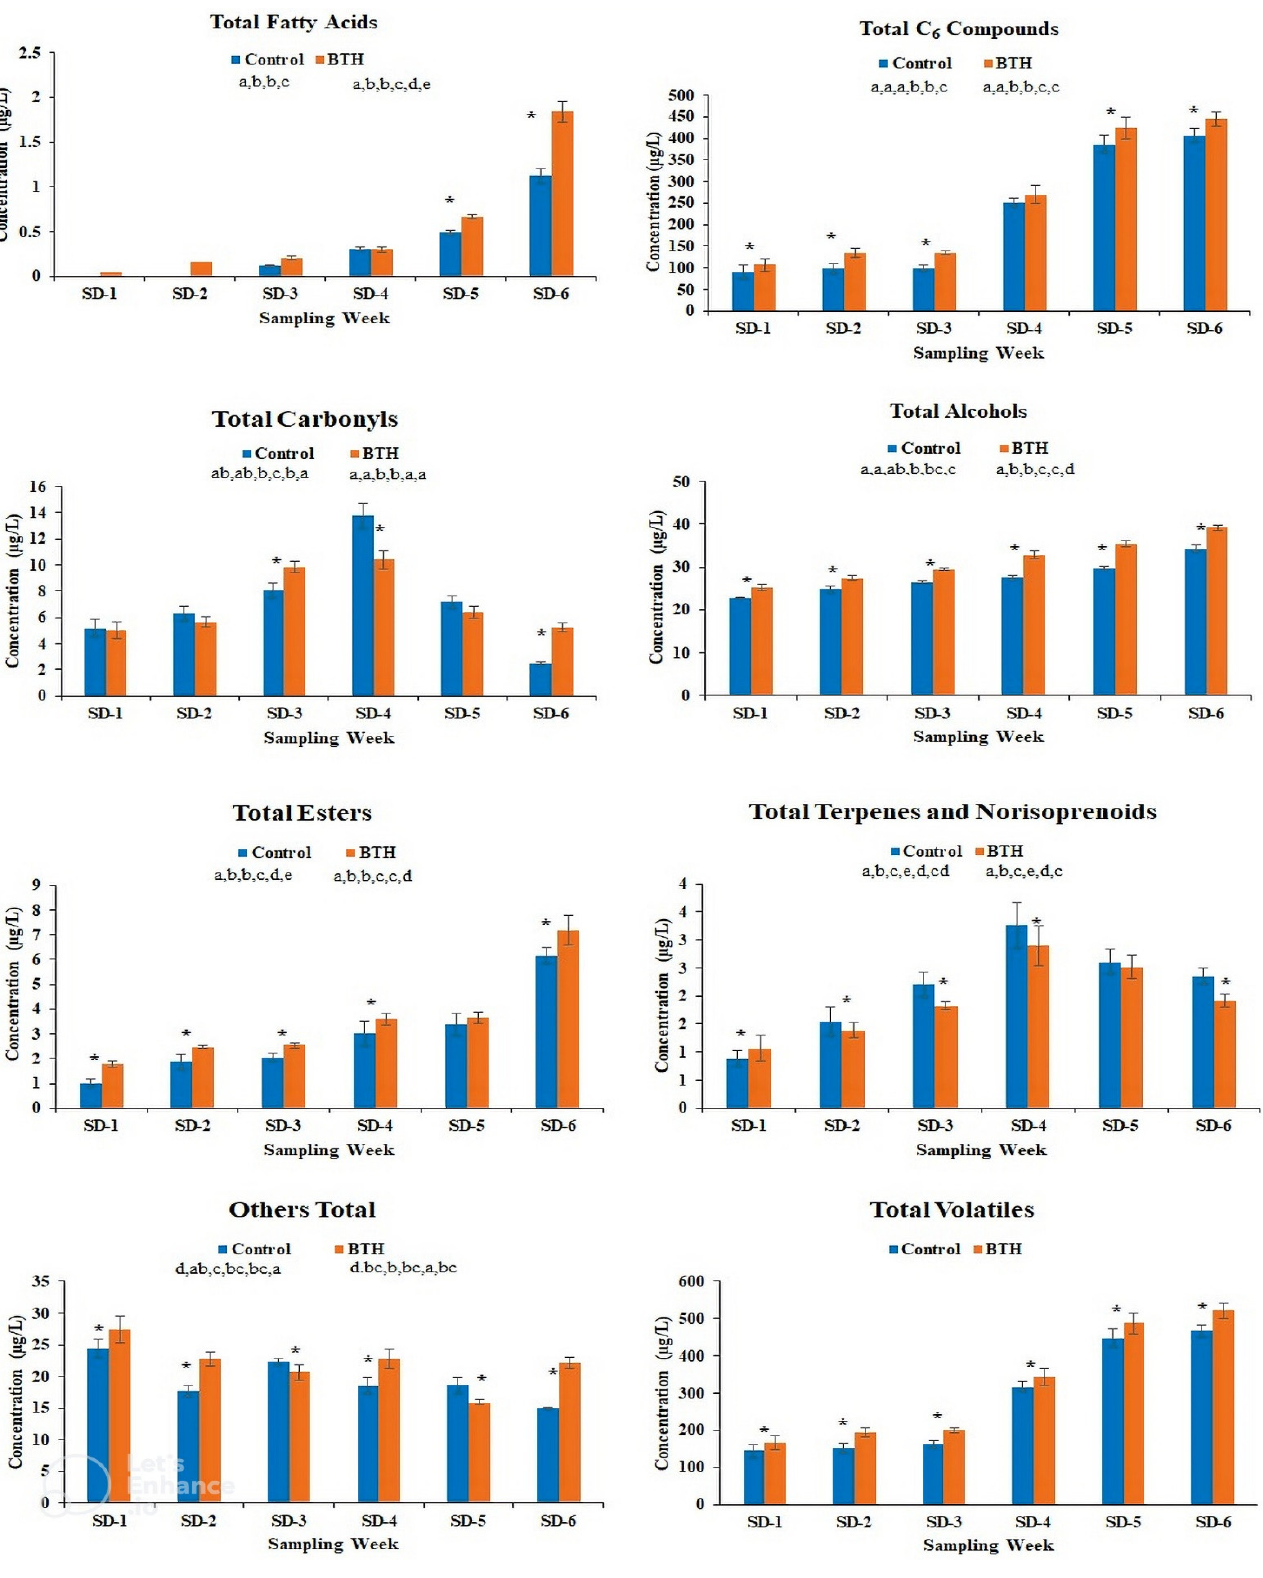
Figure 4. Total aroma compounds in control and BTH-treated Cabernet Gernischt cv grapes during development. All samples are shown with their standard deviation (n = 3). For each sampling week, an asterisk (*) indicates a significant difference between treatments (CK and BTH) at p < 0.05. For each treatment, different letters indicate differences between sampling dates ( p < 0.05). SD; Sampling Date.